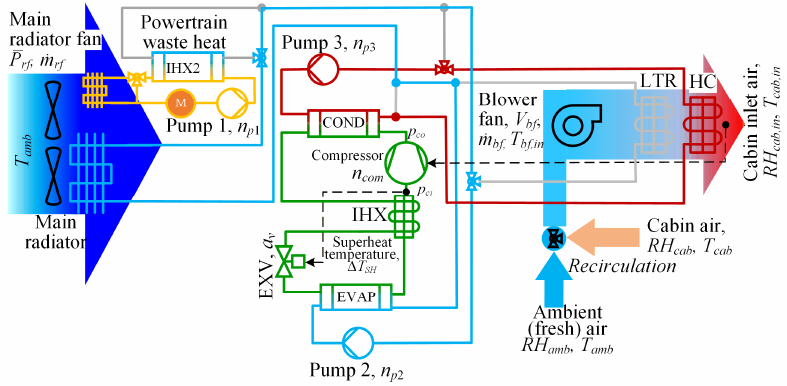
Figure 1. System schematic for heat pump (HP) mode.